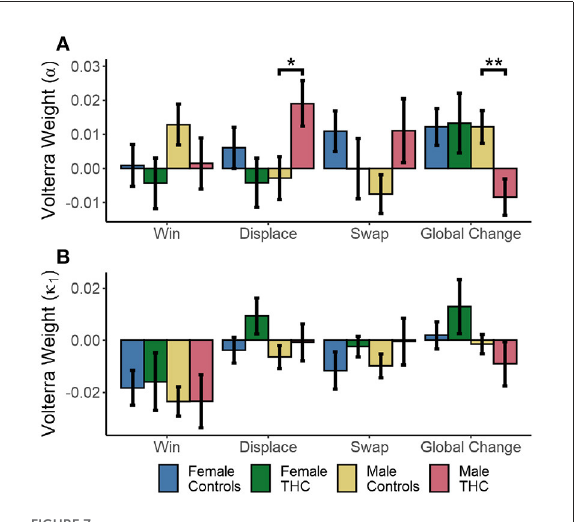
FIGURE7 Cannabis × Sex interactions on mean reinforcement learning parameter values estimated by Volterra decomposition. Learning rate α (A) and effect of wins κ 1 (B) to wins, local displacement, swaps, and global changes. SEM in error bars. * p < 0.05, ** p <